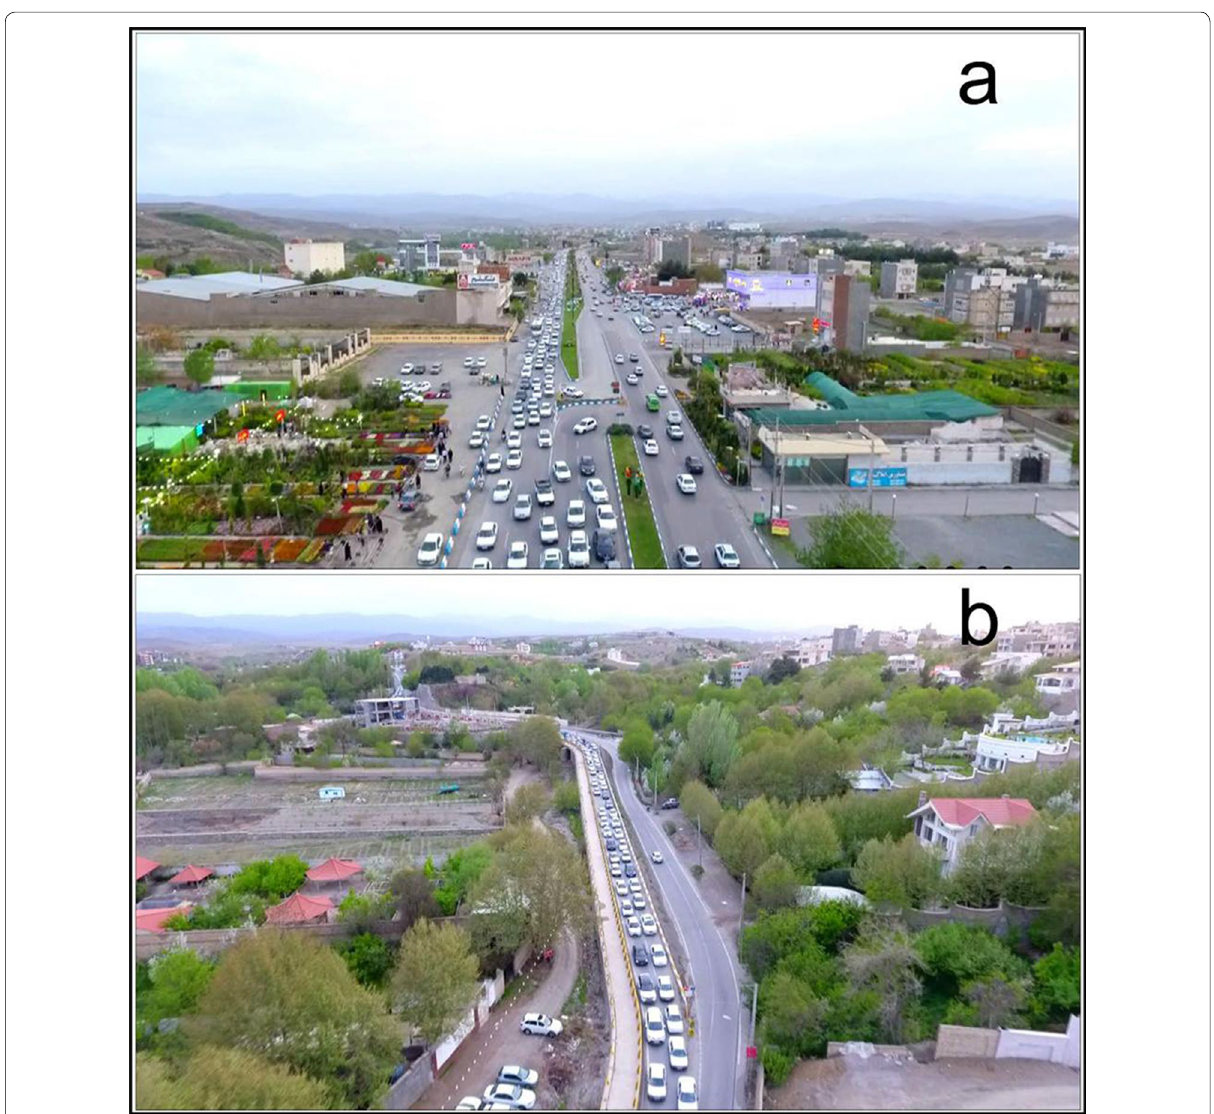
Fig. 2 General perspective of the road from the Mashhad to Torqabeh city a among the urban settlements and b among the touristic